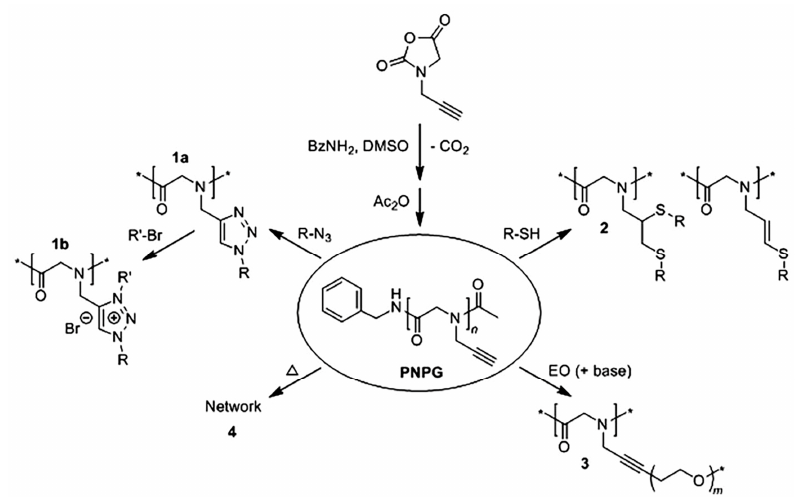
Figure 7. Synthesis of poly(N-propargyl glycine) and subsequent modifications of alkyne side chains. Reprinted with per- mission from [79] . Copyright 2015, Elsevier. Reprinted with permission from [79]. Copyright 2015,